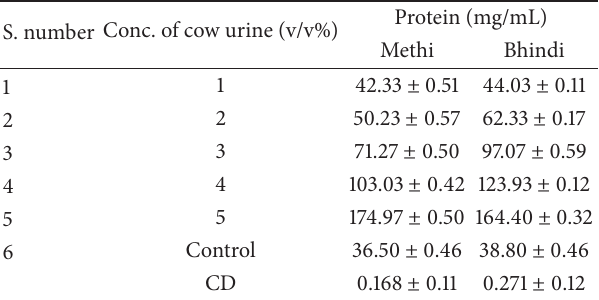
Table 4: Protein estimation of Trigonella foenum-graecum (Methi) and Abelmoschus esculentus (Bhindi) sprayed with different concen- trations of cow urine.